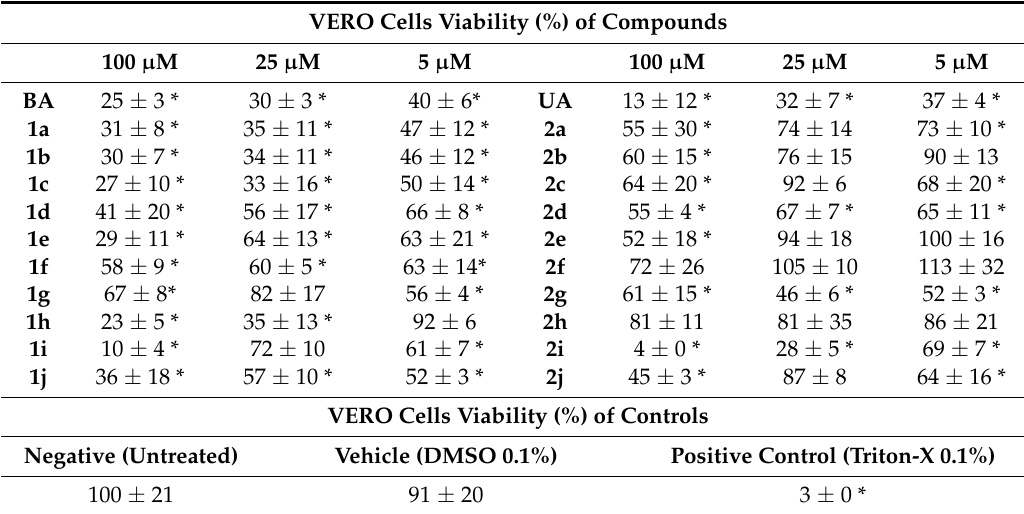
Table 1. Citotoxity activity of BA and UA and derivatives against VERO cells. VERO Cells Viability (%) of Compounds 100 µ